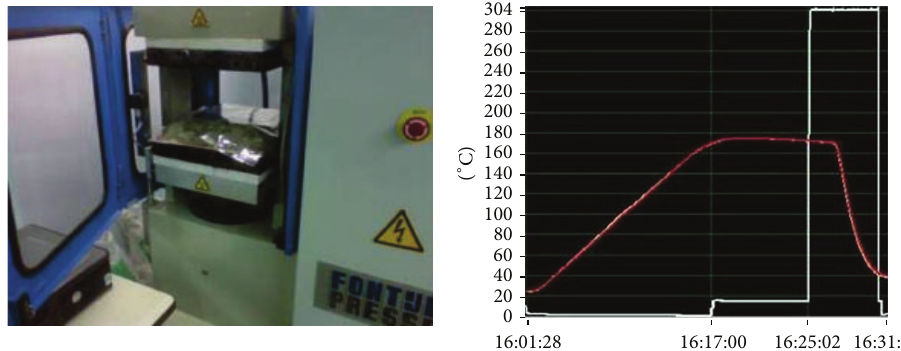
Figure 2: Manufacturing process of the boards produced from the LDPE-Al/fique